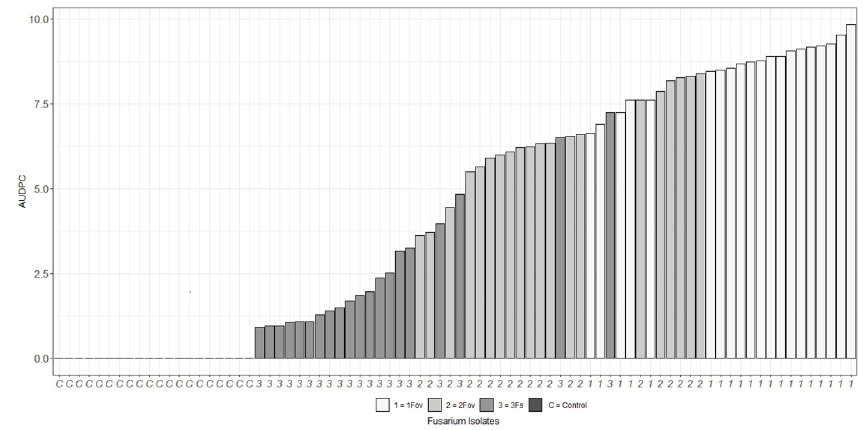
Figure 7. Fusarium wilt development gradient in vanilla accessions, calculated using the area under the disease progress curve—AUDPC. 1Fov = F. oxysporum f. sp. vanillae from leaf, 2Fov = F. oxysporum f. sp. vanillae from root and 3Fs = F. solani from root .